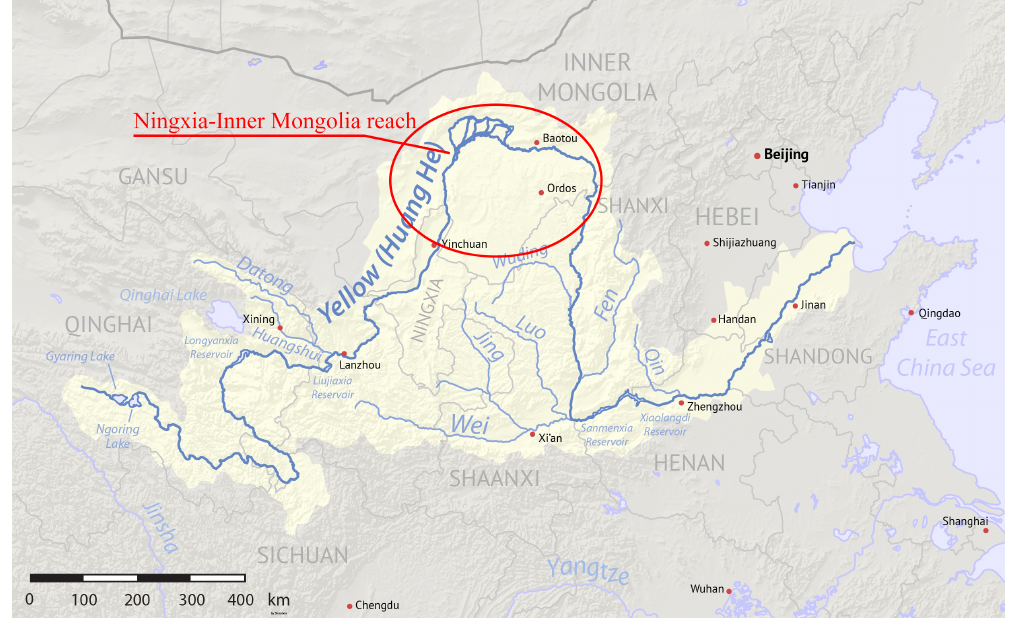
Figure 1. Our study area is indicated by the red ellipse. The base map is from the Yellow River entry in Wikipedia